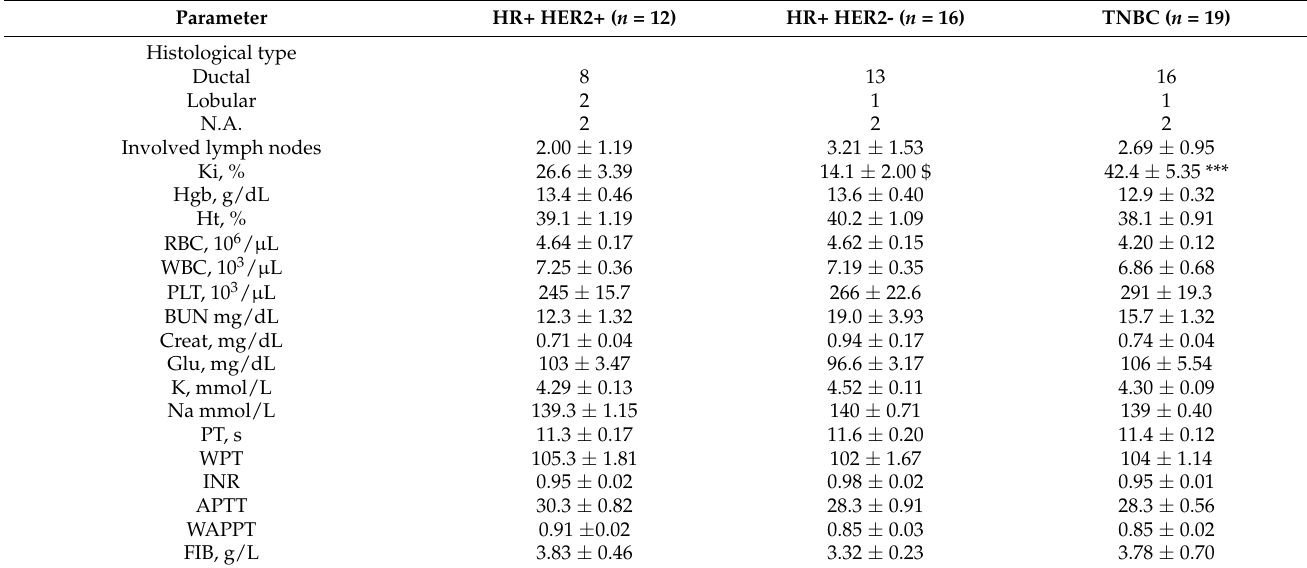
Table 2. Characteristic of breast cancer patient